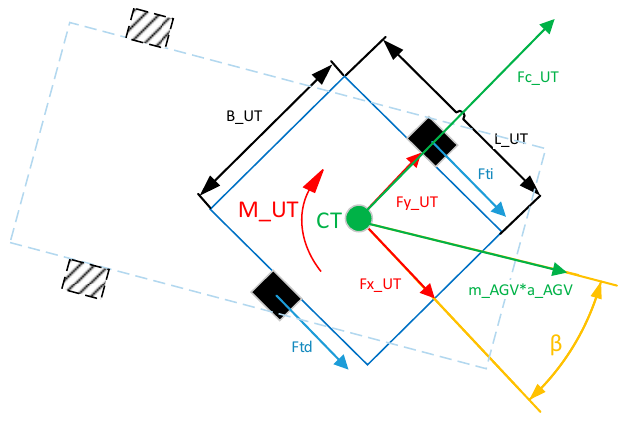
Figure 6. Model of the traction unit.